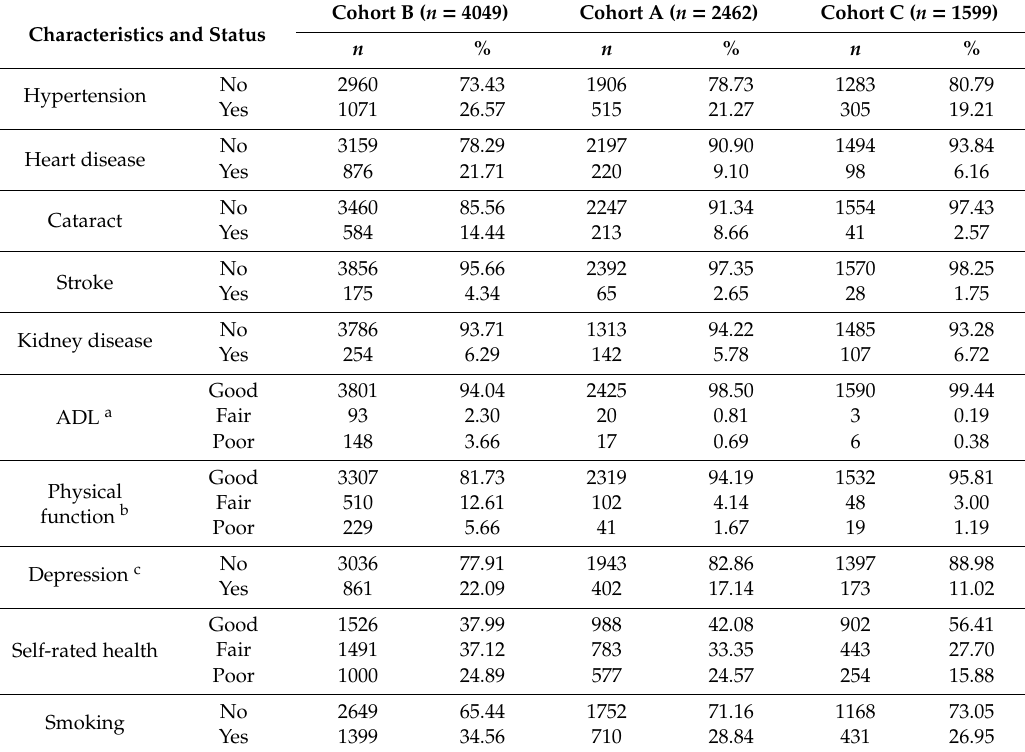
Table 2. Characteristics and status of di ff erent cohorts at the baseline survey